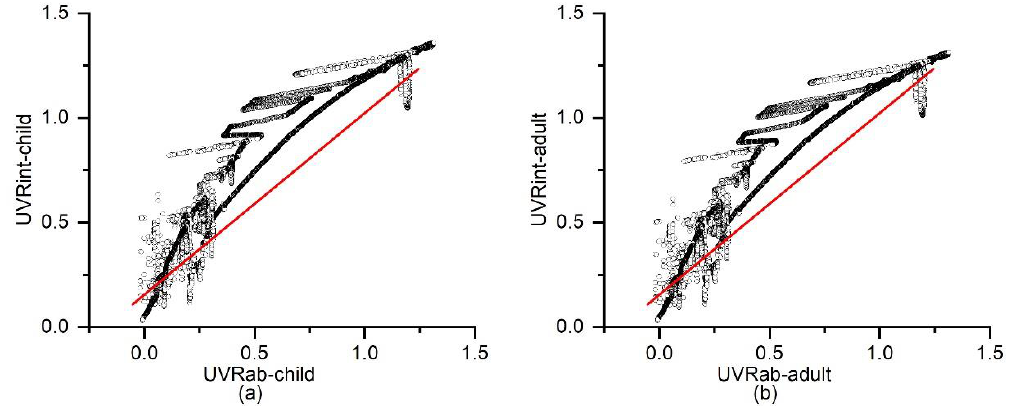
Figure 2. Adults’ UVRab and UVRint on 25 February 2020.